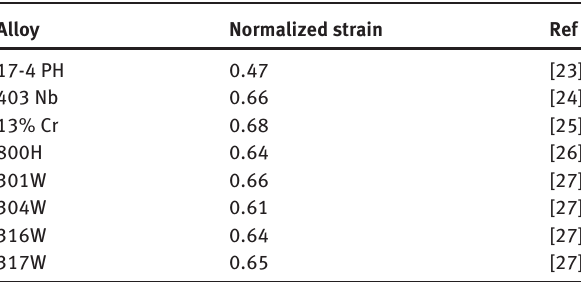
Table 2: Some values of normalized strain for typical stainless steels in previous literature Alloy Normalized strain